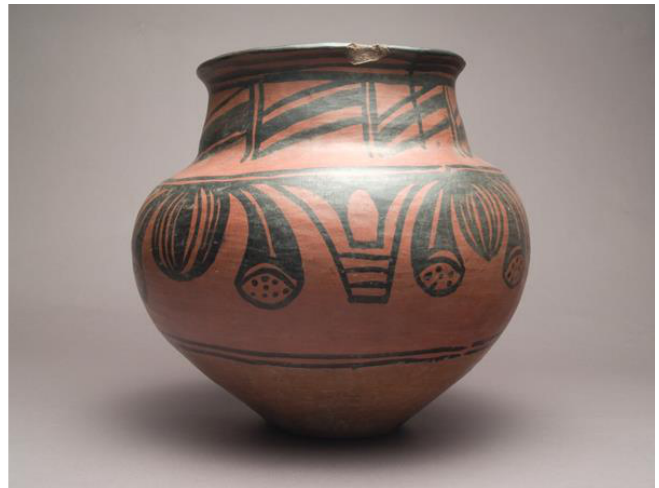
Figure 8. Dominguita Pino and Crescencio Martinez, Jar, 1905–1910. Courtesy of the Museum of Indian Arts and Culture, Laboratory of Anthropology, Santa Fe, NM, 12229/12.